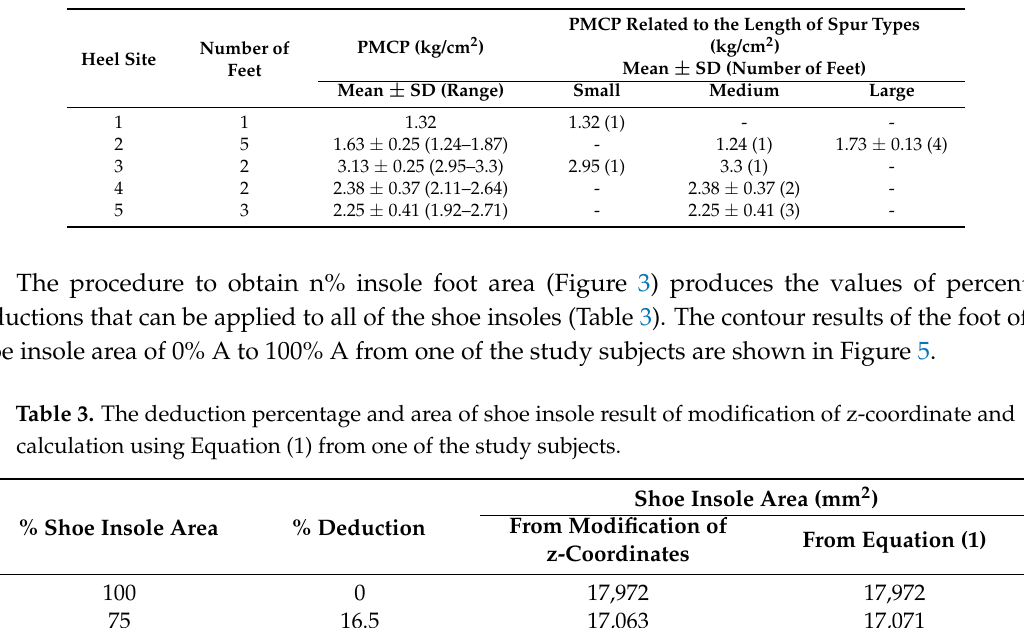
Table 2. The pain minimum compressive pressure (PMCP) values at each heel site.